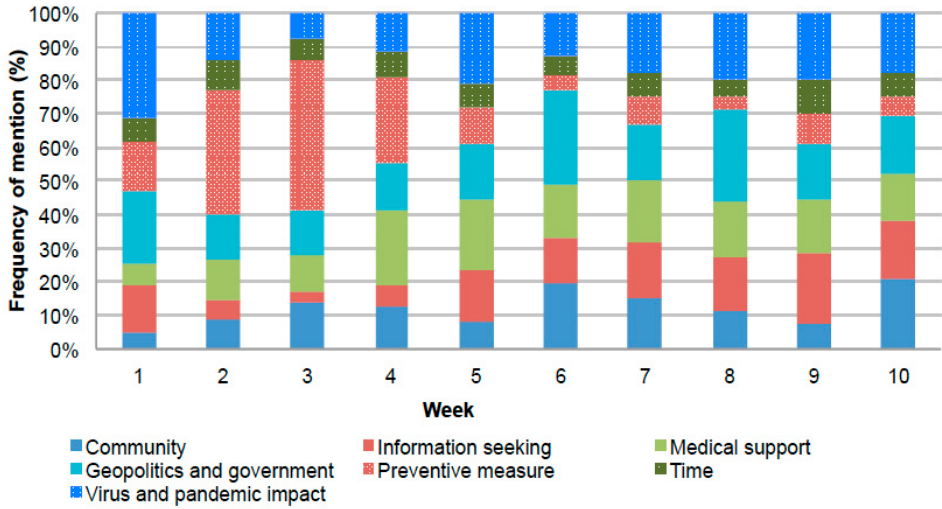
Figure 4. Frequency of mention of themes over weeks.